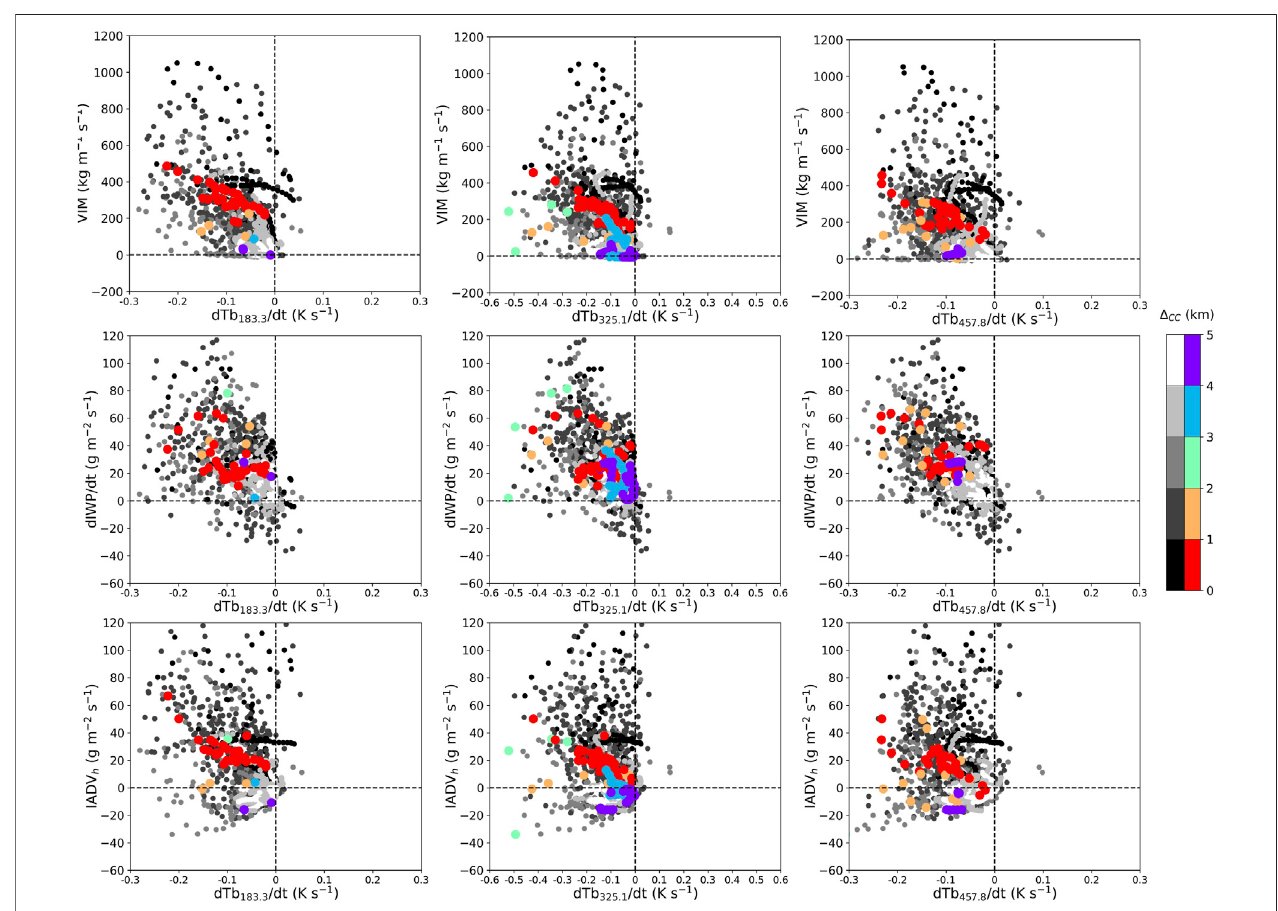
FIGURE 7 | Same as Figure 6 for the selected convective cells in HEC and RCE.